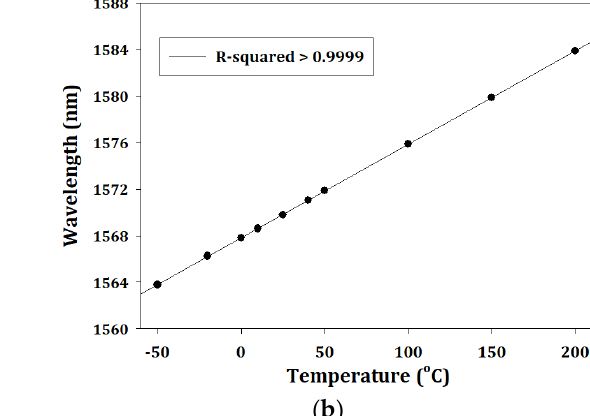
Figure 5. ( a ) The simulation output spectrum and ( b ) the trends in peak wavelength with different temperature.